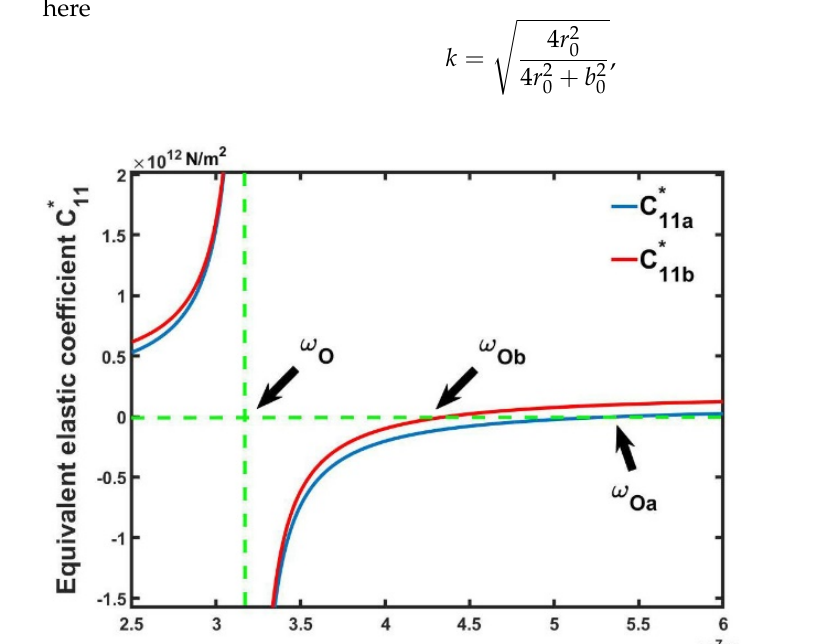
Figure 3. Calculated the first − order (n = 1) equivalent elastic coefficient curves of the MPPC. The solid lines represent the real part of the equivalent elastic coefficients 𝐶 (cid:2869)(cid:2869)(cid:3028)∗ and 𝐶 (cid:2869)(cid:2869)(cid:3029)∗ . The functions exhibit negative values in the frequency gaps ( 𝜔 (cid:3016) , 𝜔 (cid:3016)(cid:3028) ) and ( 𝜔 (cid:3016) , 𝜔 (cid:3016)(cid:3029) ).